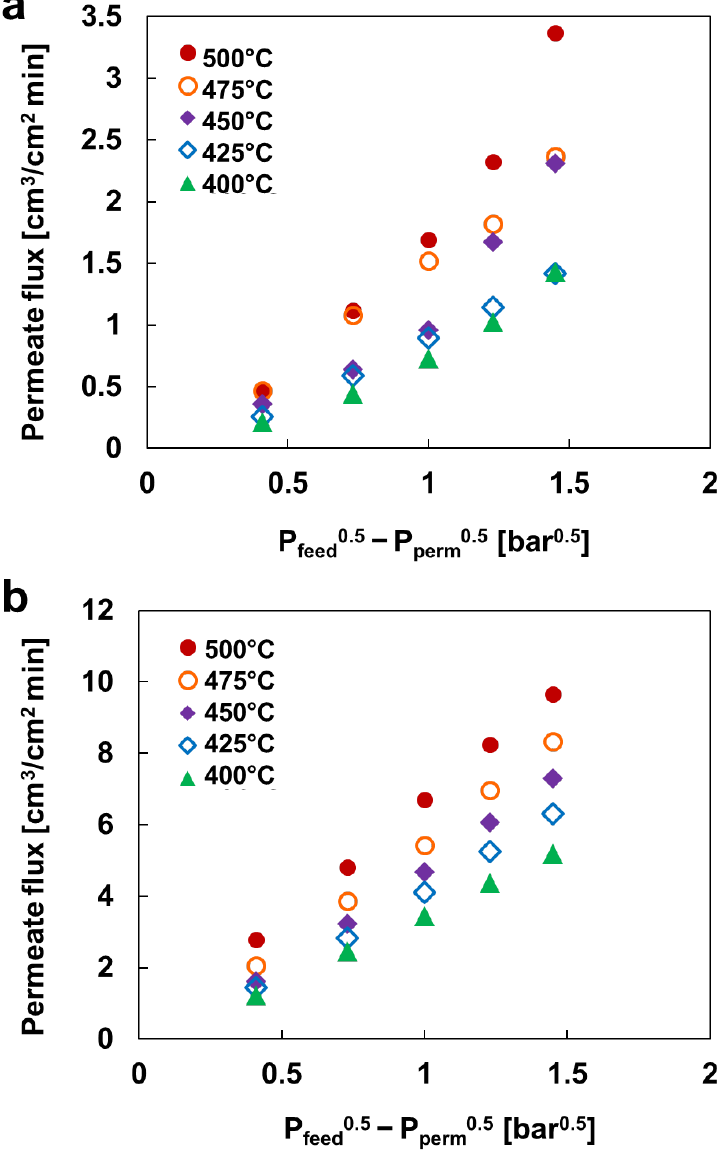
Figure 7. H 2 permeability of ( a ) PdCu(co-SPT)/Ta and ( b ) Pd(ELP)Cu(SPT)/Ta membranes. Moreover, the maximum permeability obtained for the PdCu/Ta membrane was 4.4 × 10 −8 mol H2 m −1 s −1 Pa −0.5 which is more than the reports on PdCu membranes with permeabilities ranging from 0 to 2.75 × 10 −8 mol H2 m −1 s −1 Pa −0.5 [54]. The H 2 permeability in the Pd(ELP)Cu(SPT)/Ta membrane was ~60% of that in the Pd/Ta mem‑ brane. However, it exhibits excellent durability at high temperatures, where the n